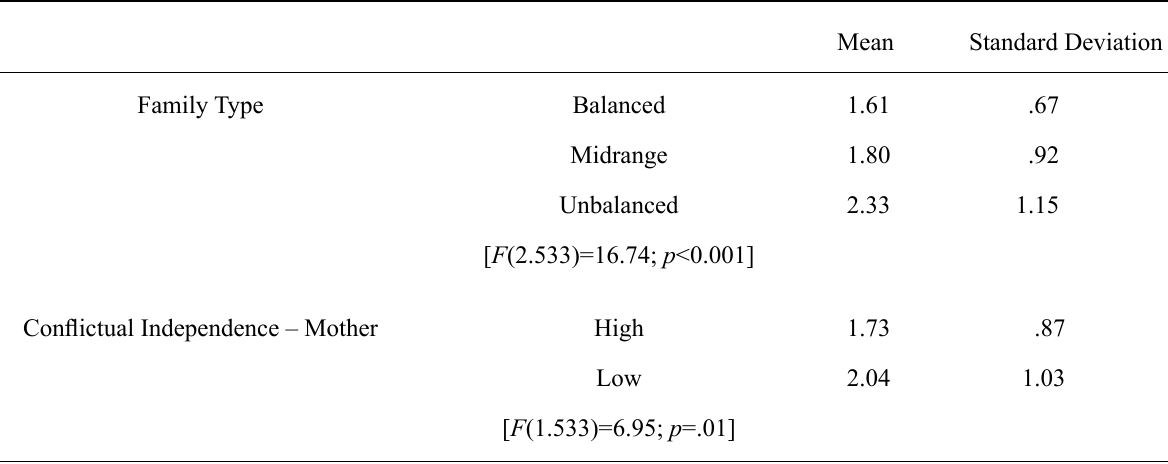
Means of Individuals Concerning the Main Effects of Variables Family Type and Con fl ictual Independence from Mother in Suicidal Ideation